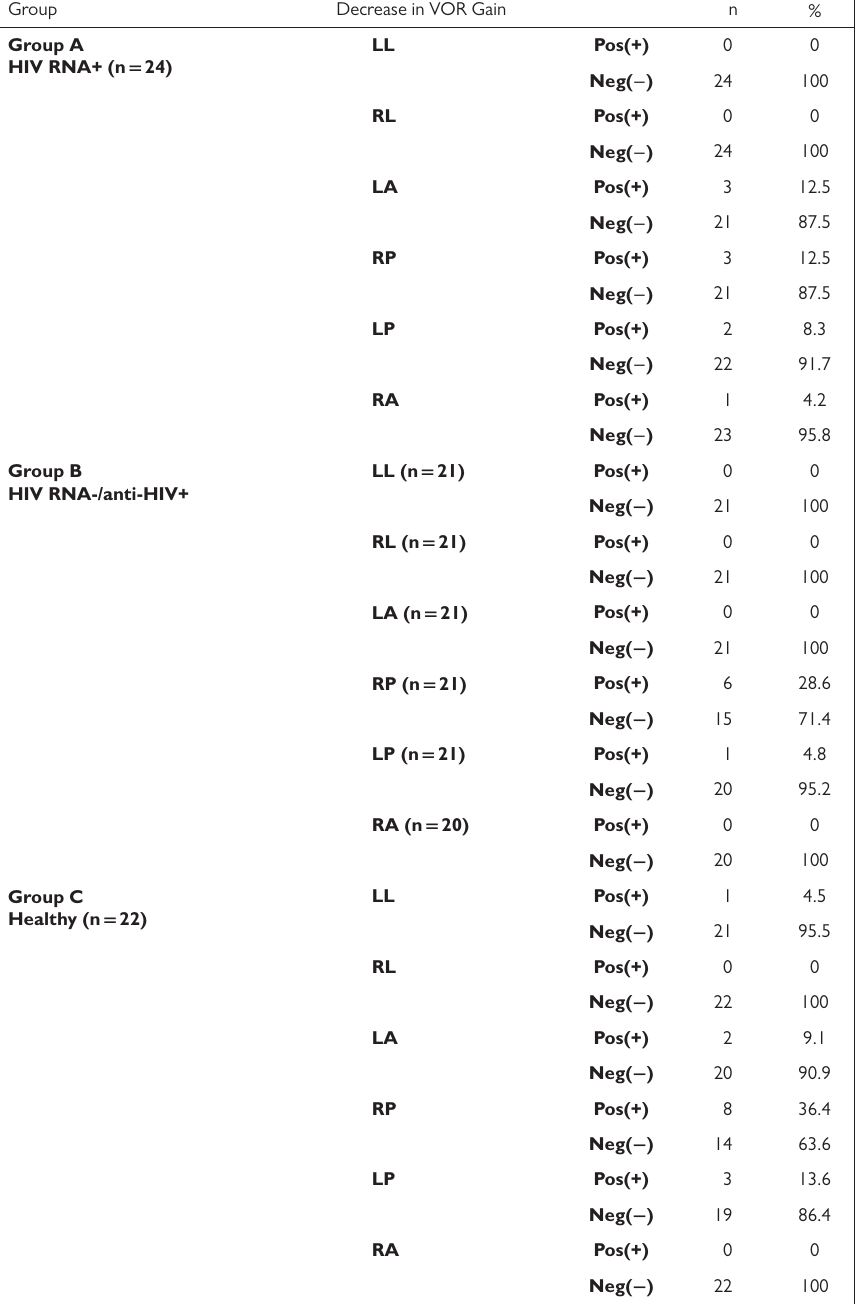
LL, left lateral semicircular canal; RL, right lateral semicircular canal; LA, left anterior semicircular canal; RP, right posterior semicircular canal; LP, left posterior semicircular canal; RA, right anterior semicircular canal; HIV, human immunodeficiency virus; VOR, vestibulo-ocular